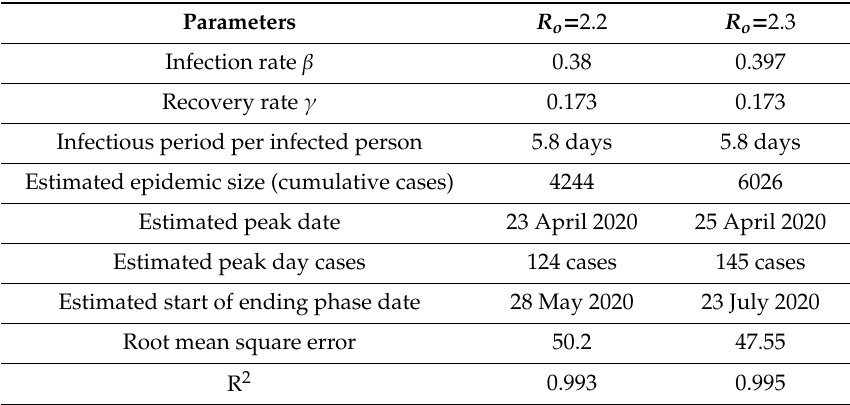
Table 6. SIR simulation parameters with various reproduction